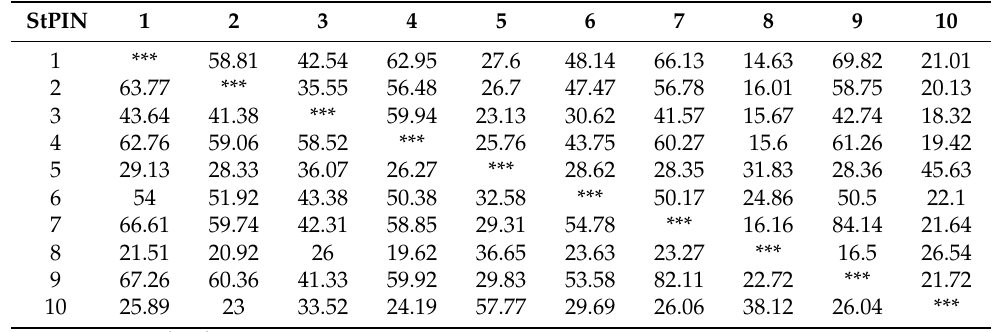
Table A3. Percent ORF nucleotide (bottom–left) and amino acid (up–right) identities of StPINs.